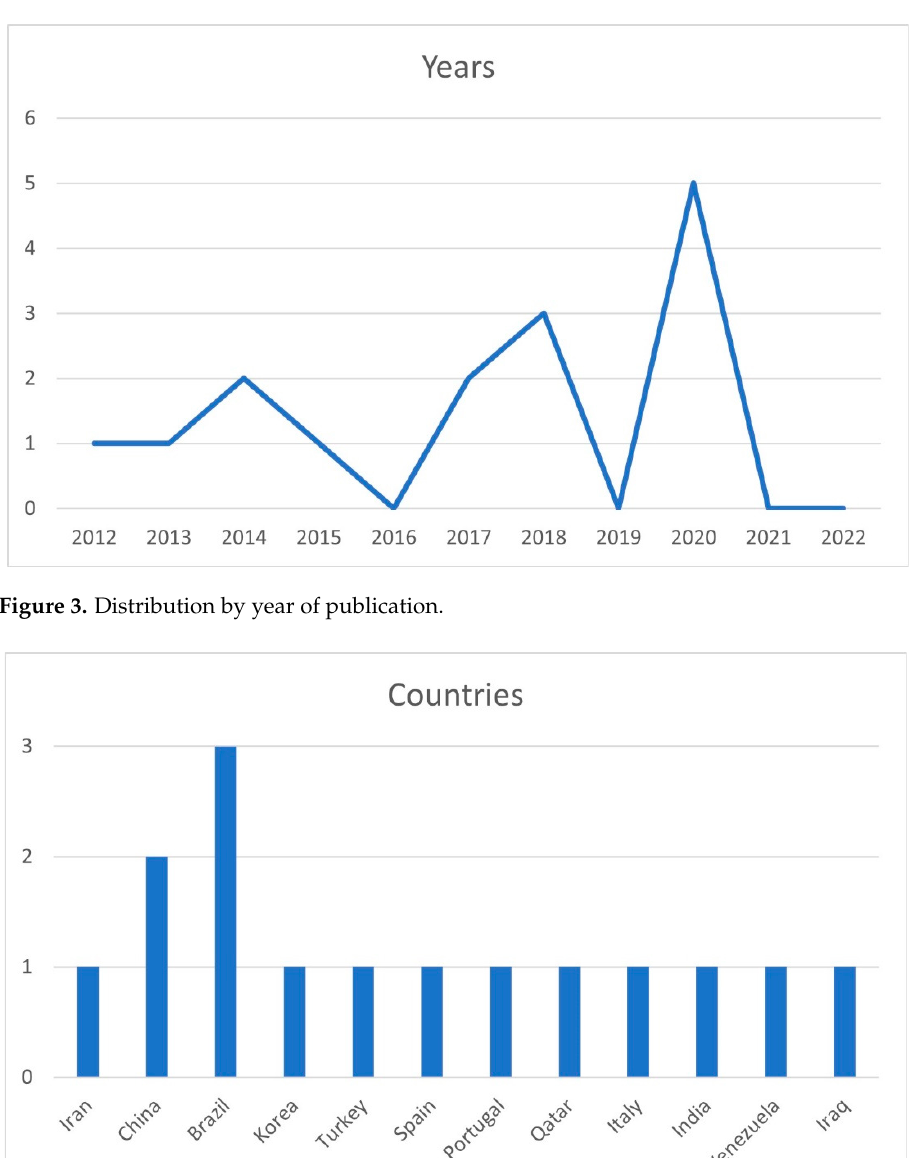
Figure 4. Distribution by country of publication.